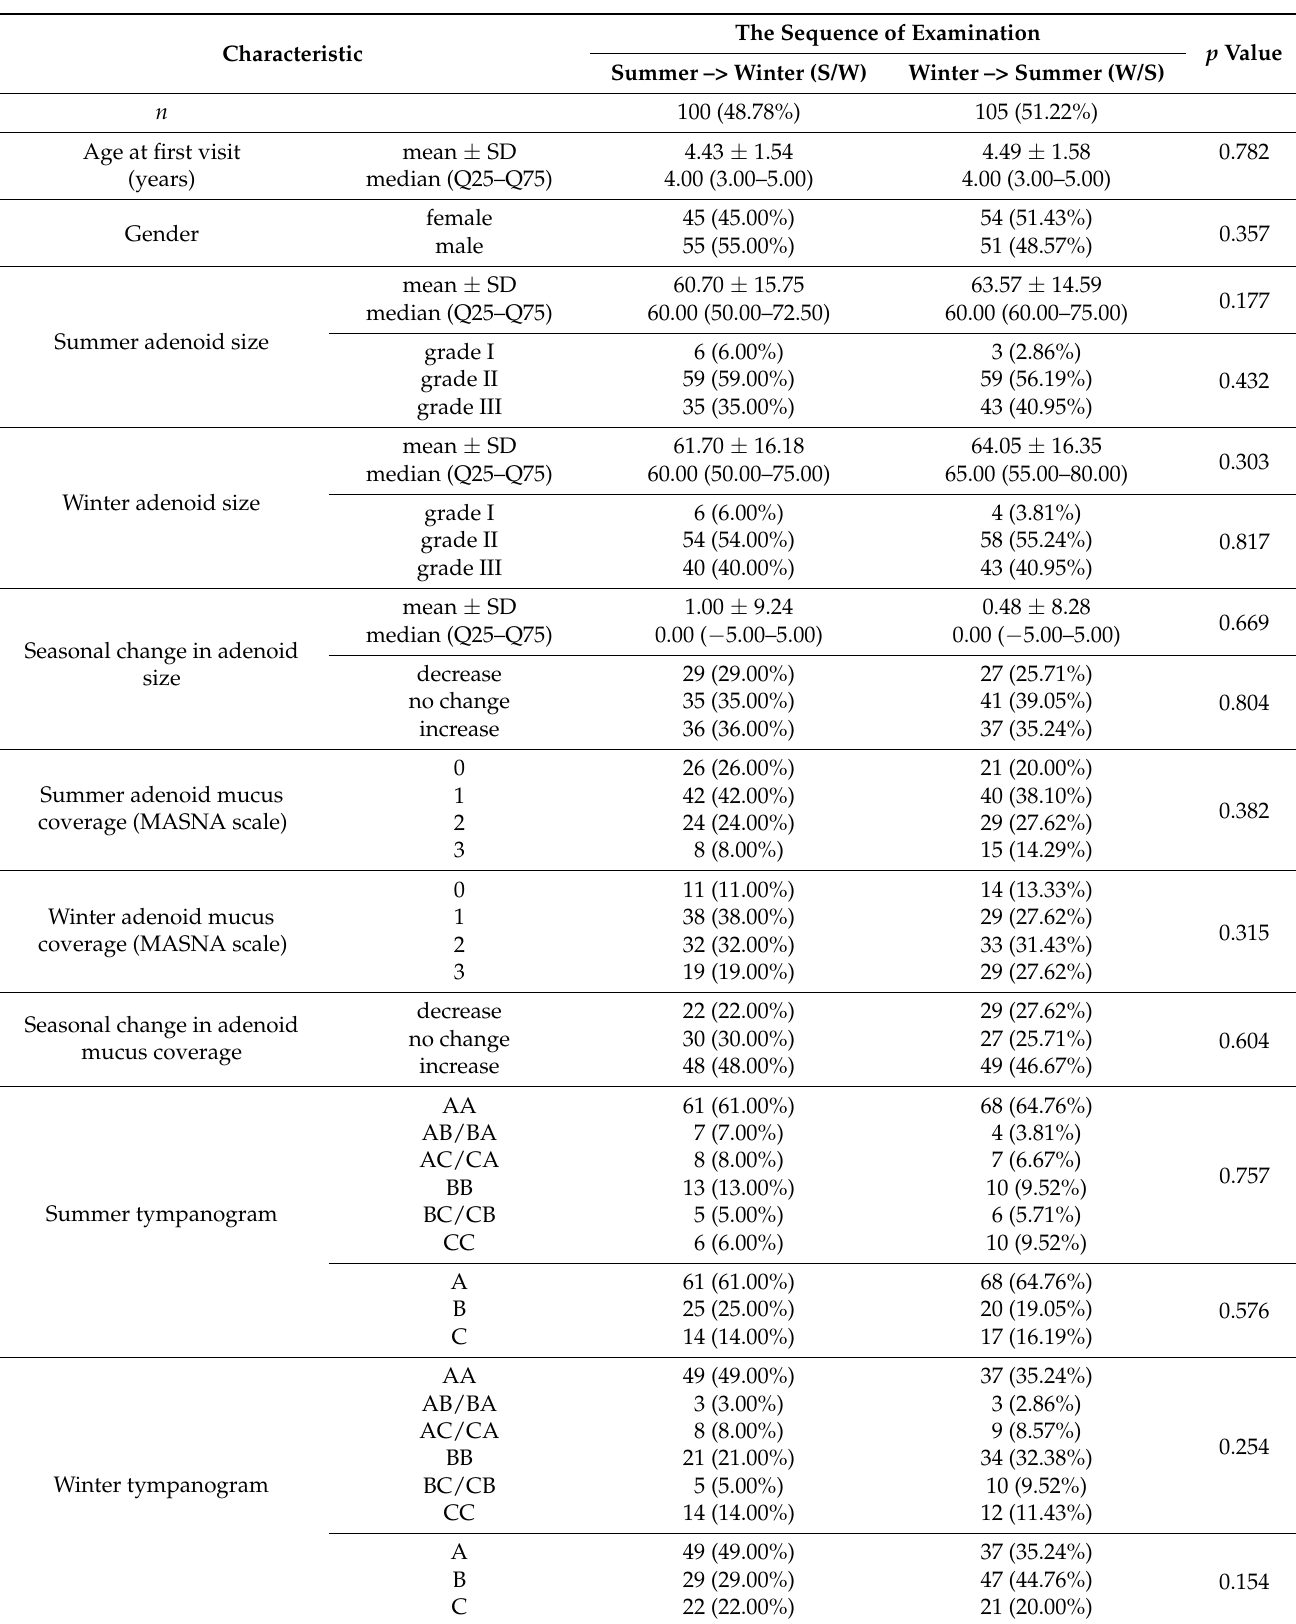
Table 2. Relationship between sequence of examination and clinical and demographic